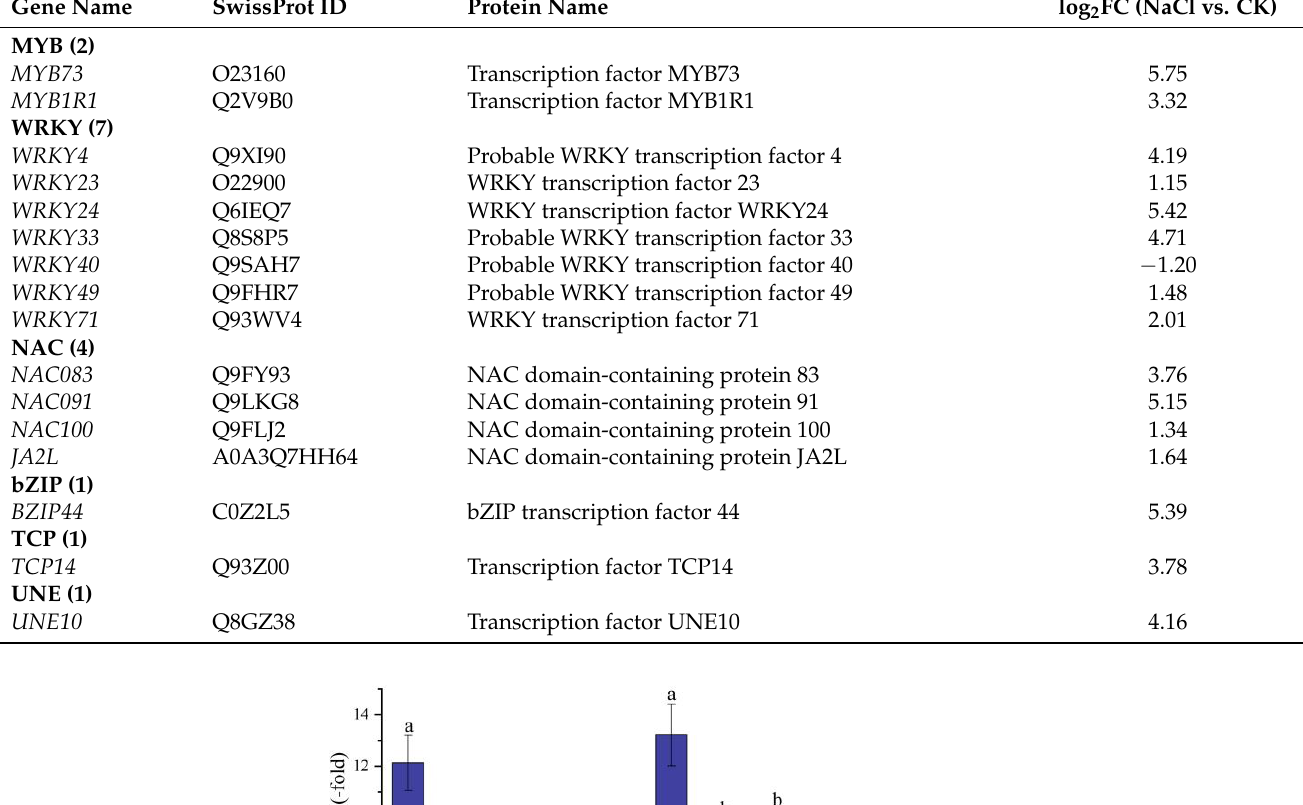
Table 6. Sixteen TFs directly associated with stress response and seed germination at 300 mmol/L NaCl vs. CK.